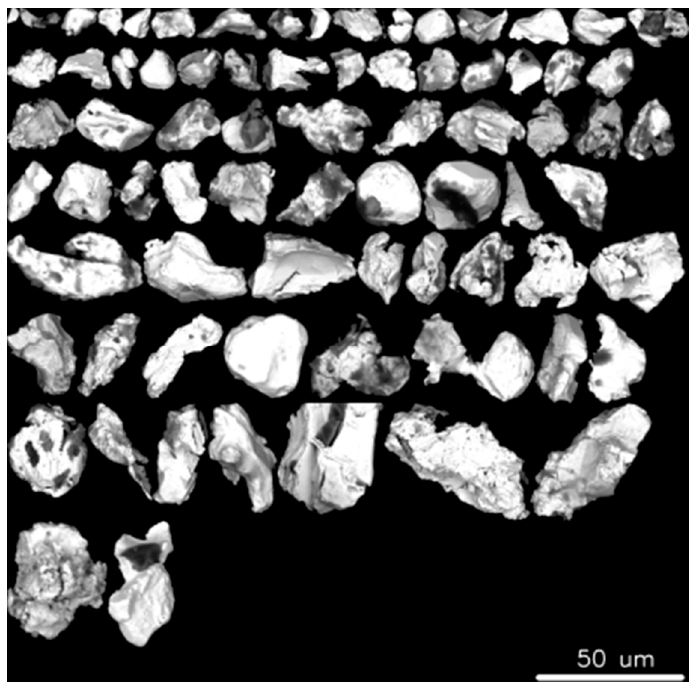
Figure 14. Mosaic of gold grains recovered from milling circuit of a mine concentrator. Notice that for the vast majority of grains, the initial shapes were not significantly modified by milling. Similar observations were made in materials from various mines located in the Abitibi, northern Québec.